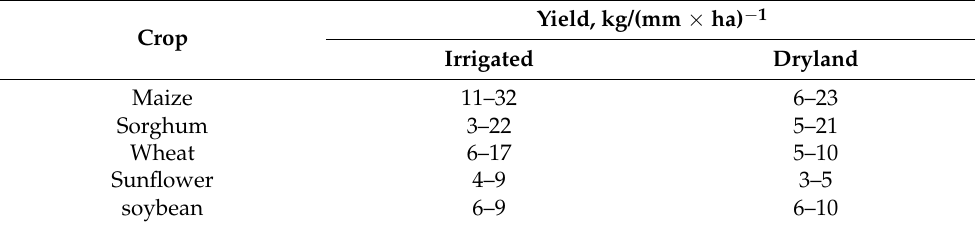
Table 6. Water productivity.